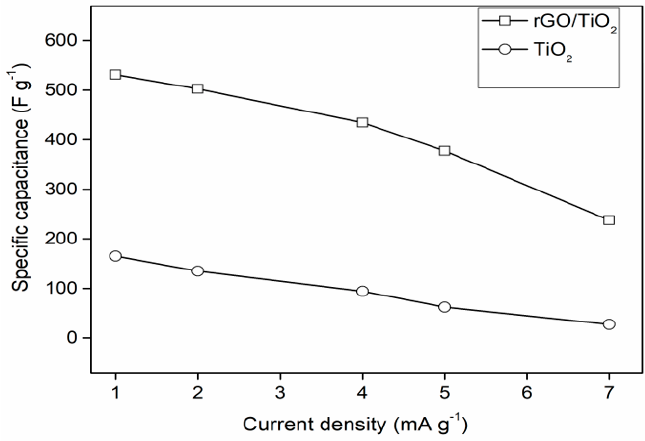
Figure 7. Current density versus specific capacitance.